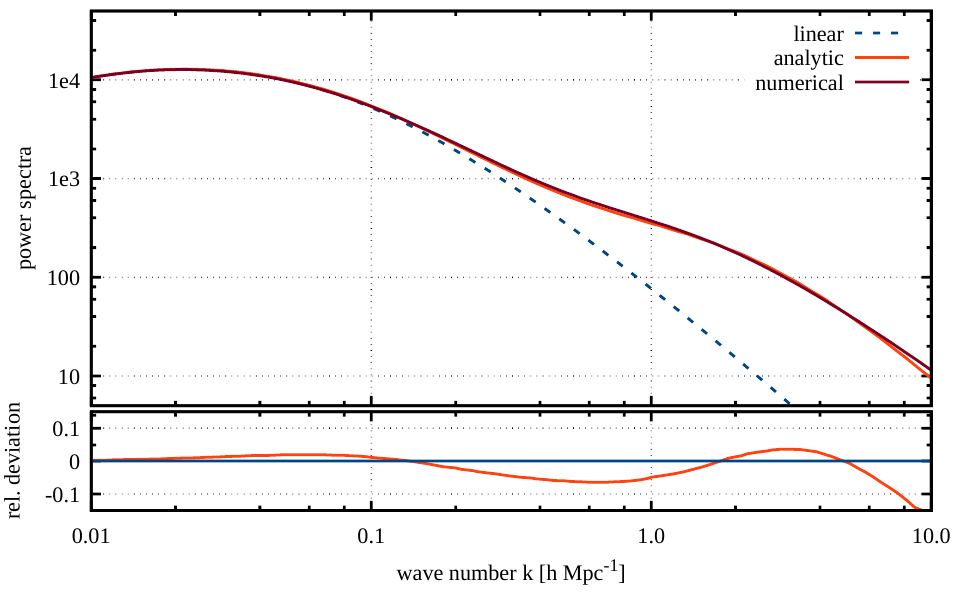
Figure 3: Like Fig. 2, but with the parameters ν and k agreement with the numerical results by [ 10 ]